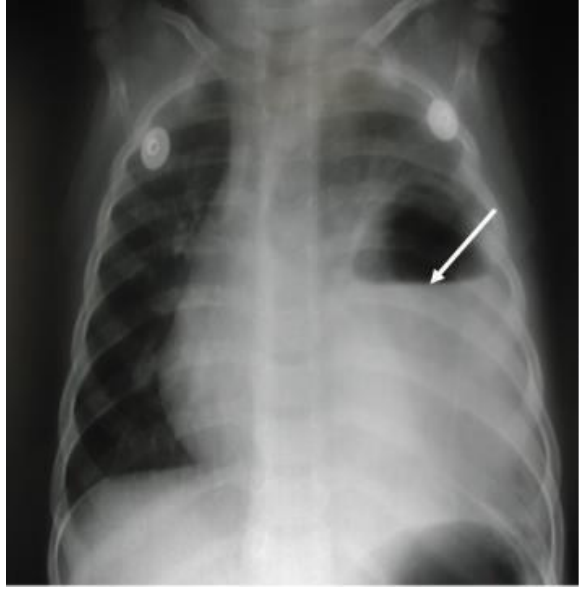
Figure 3. Chest X-ray, AP film, large homogenous density occupying most of the side of the he- mithorax with a large amount of air fluid in the superior aspect, which was consistent with a large lung abscess. There was still some shift of the mediastinum to the right, with mild hyperinflation on the right side of the lung.